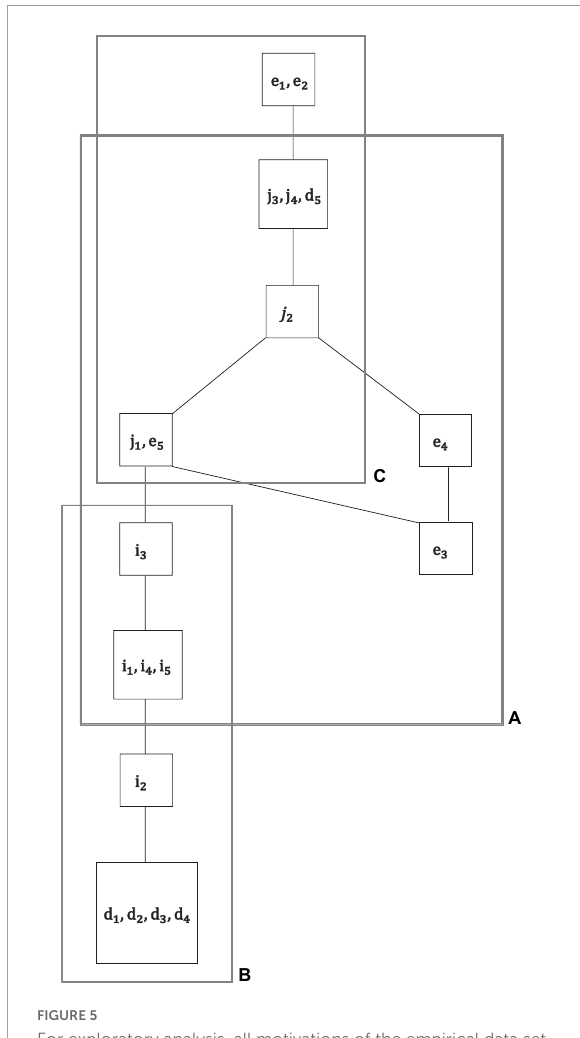
FIGURE5 For exploratory analysis, all motivations of the empirical data set were jointly analyzed M = M i ∪ M e ∪ M d ∪ M j . The sample size of N = 180 students for a total of k = 19 motivations was small for an overall IITA computation. Thus, based on the exploratory global solution (this figure), collections of motivations were delineated that were further analyzed more reliably, in lower numbers of jointly scaled motivations with larger sample sizes. In this example, the three subsets of motivations A , B , and C were regarded to be adequately sized and located within the overall graph for subsequent, more refined IITA analyses ( Figures 6A–C